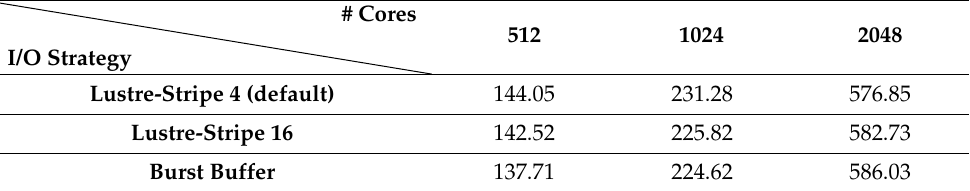
Table 3. Computational walltime (seconds) for the initialization of MPAS under two additional I/O strategies with 512, 1024, and 2048